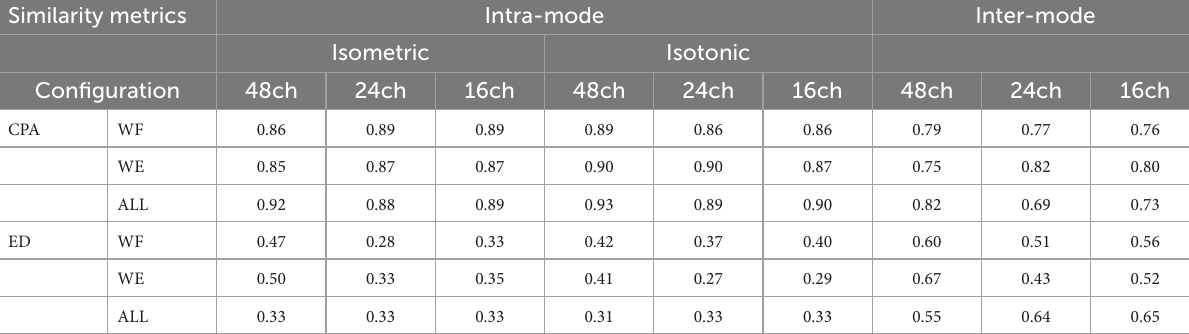
TABLE 1 Comparison of intra-mode and Inter-mode similarity of muscle synergies. Similarity metrics Inter-mode Isometric Isotonic Configuration 48ch 24ch